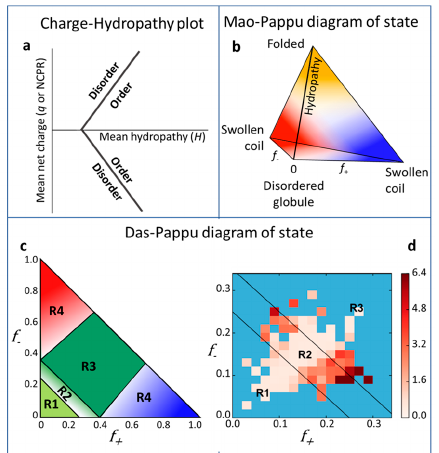
Figure 1. Conformational phase diagrams. ( a ) Uversky’s plot of mean net charge ( q or NCPR) versus hydropathy ( H ). The two solid lines mark the boundary between disordered and folded proteins [27,28]. ( b ) Mao-Pappu’s phase diagram of conformations for intrinsically disordered proteins (IDPs) and protein regions (IDRs). The three-dimensional sequence space is defined by f + , f − , and mean hydropathy. Since high hydropathy and high fractions of charged residues are mutually exclusive, the space is shaped as a pyramid. The yellow area, at the top of the “pyramid”, represents naturally folded proteins, the red and blue regions at the base correspond, respectively, to negatively and positively charged polyelectrolytes (figure inspired by [29]). ( c ) Das-Pappu’s phase diagram of IDP / IDR conformations. The diagram contains four regions (R1-R4) representing distinct conformational classes. R1, weak polyampholytes or weak polyelectrolytes that form globules or tadpole-like conformations. R3, strong polyampholytes that form non-globular conformations, such as coil-like, hairpin-like, or a mixture. R2, continuum of conformations between those in R1 and R3. R4, strong polyelectrolytes with FCR > 0.35 and | NCPR | > 0.3, which sample coil-like conformations approaching the excluded-volume limit [32]. ( d ) Heat map of the protein size distribution predicted by the analytical Ghosh’s model applied to the DisProt entries. The bins correspond to ( f + , f − ) classes. The color scale represents the values of x , an expansion index calculated for each protein comparing the ensemble-averaged end-to-end distance predicted by Ghosh’s model with the ensemble-averaged end-to-end distance in the Flory random coil limit, in the absence of any interaction, at T = 300 K. The map represents with color of di ff erent intensity the average of x values among proteins within a given bin. Blue bins correspond to classes containing less than two proteins. Black lines define R1, R2, and R3 regions as reported in panel C. Reproduced from [33] with the permission of AIP